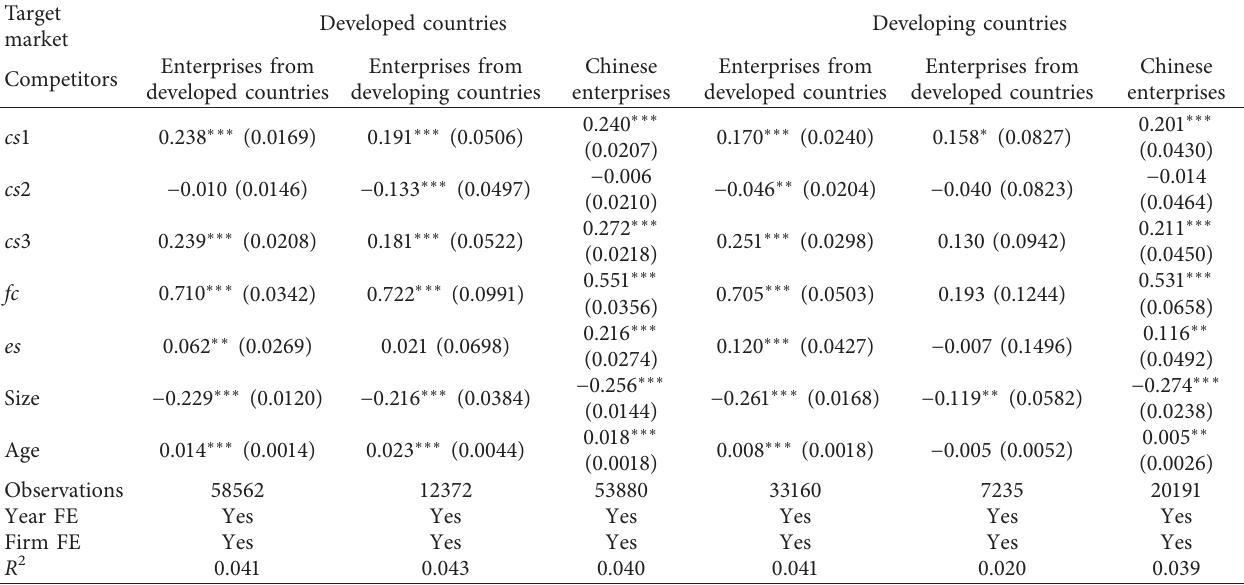
Table 4: The estimate of subsamples classified by target market and competitors.